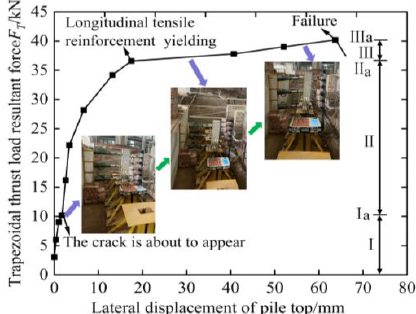
Figure 12. Variation curve of the thrust load with the pile top displacement.